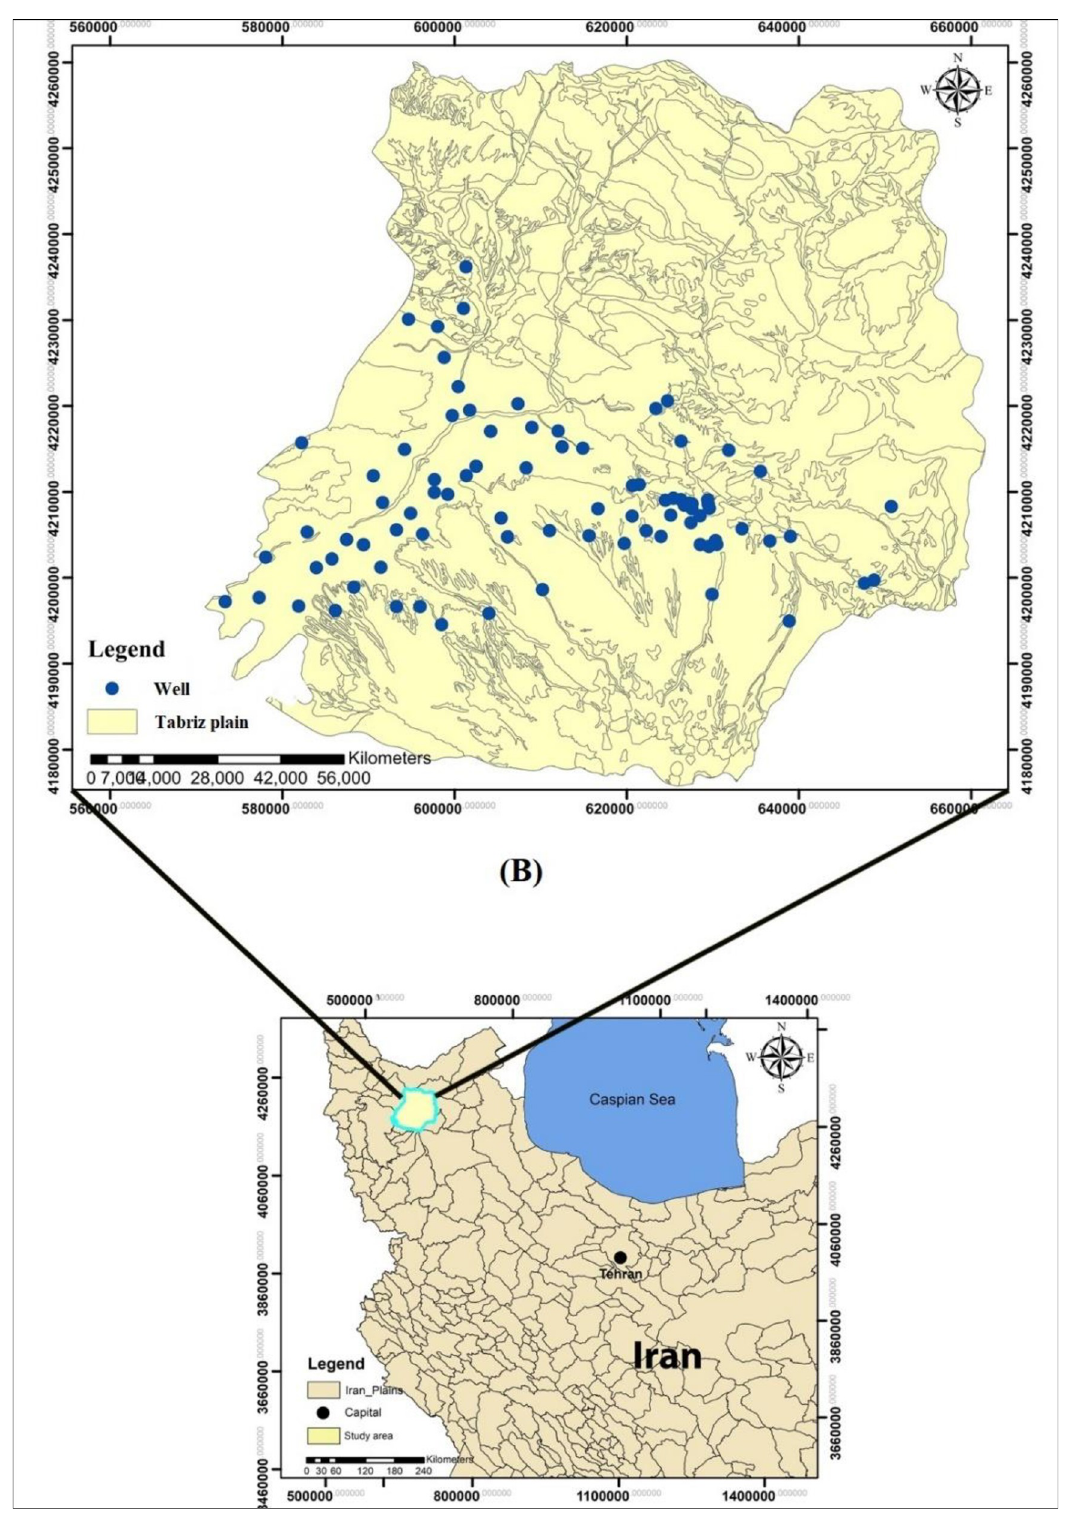
Fig 2. The selected case study at the Tabriz Plain, Iran.